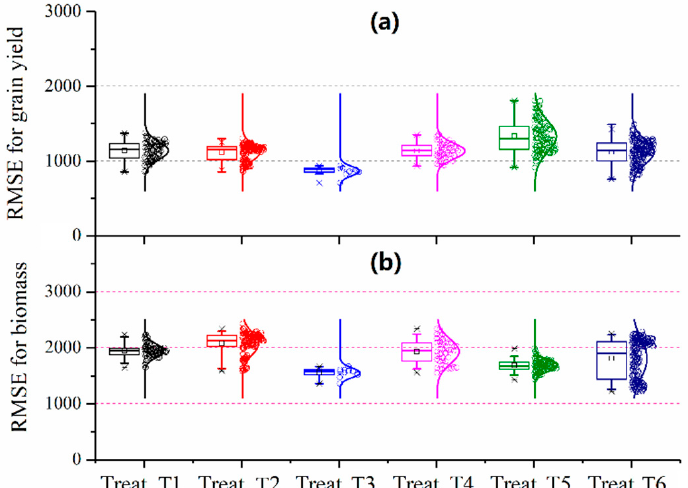
Figure 6. Box plots for RMSE (Root Mean Square Error, kg ha -1 ) values for simulated grain yield ( a ) and biomass ( b ) calculated from the selected cases within 10% calibrated minimum Φ values from the 300 cases generated by the Latin hypercube sampling (LHS) for Treat_T1 to Treat_T6 (Table 3). The boxplots show the minimum and maximum (asterisks), medians (lines), and means (dots). The 25% and 75% percentiles are shown as the tops and bottoms of the boxes, and the 5% and 95% percentiles are shown as the whiskers below and above the